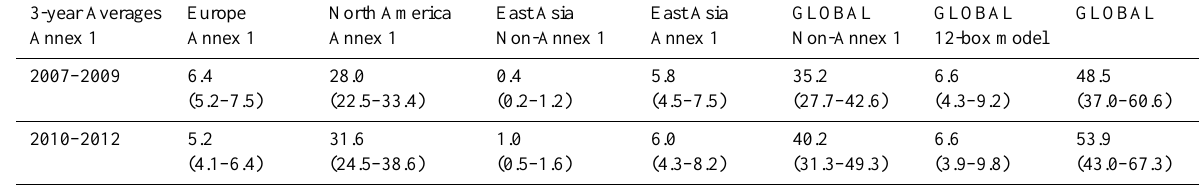
Table 3. Annex 1 and non-Annex 1 global and regional emissions in Ggyr − 1 averaged over two 3-year periods. Values in the final column are from the 12-box model, all other values are from the combined Eulerian and Lagrangian model of Lunt et al. (2015). The global estimates from the 12-box model are not in exact agreement with the combined Annex I and non-Annex I emissions reported in Lunt et al. 2015. However, this is not unexpected, given the vastly different transport and inversion models used to estimate these terms. We note that the uncertainty range of the combined Annex I and non-Annex I estimates does overlap with the uncertainty range from the 12-box model, and a similar growth in emissions is seen across the two averaging periods.